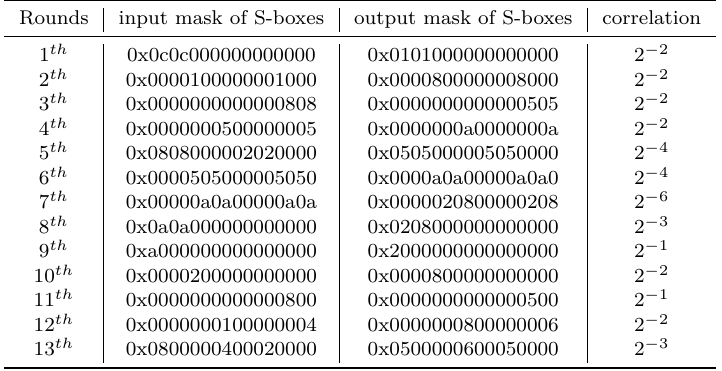
Table 11: The best linear characteristic with correlation 2 − 34 for 13-round GIFT-64